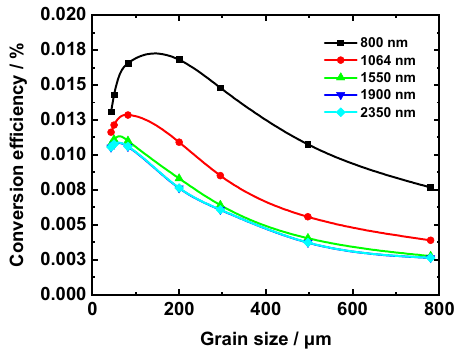
Figure 9. The conversion efficiency of RQPM OR versus ZnSe grain size at different central pump wavelengths of 800, 1064, 1550, 1900 and 2350 nm. Note the curves of 1900 and 2350 nm are over- lapped.